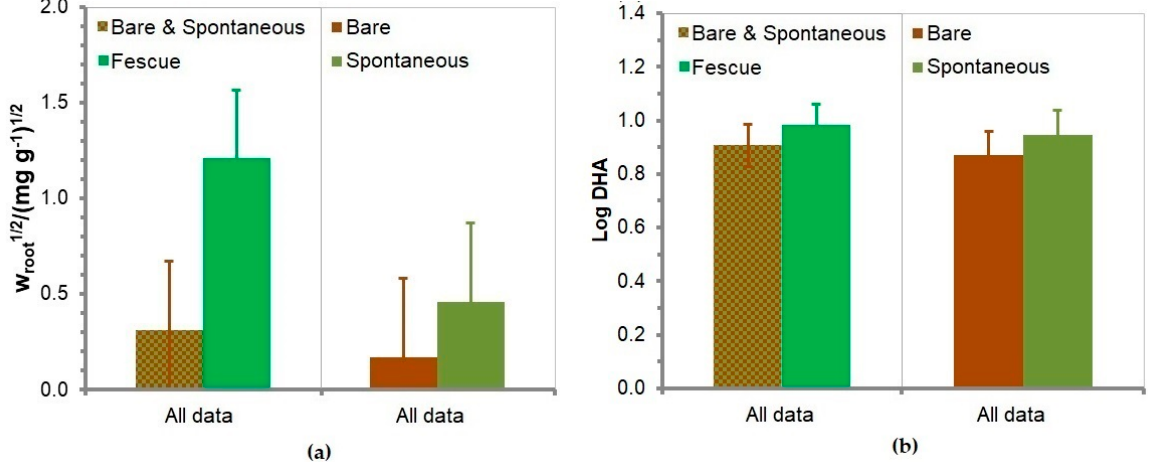
Figure 5. ( a ) Square root of the soil root mass fraction ( w root1/2 ) at 0–5 cm in the different treatments alongside the 95% confidence interval for the means according to the orthogonal contrasts based on the two-way ANOVA results; ( b ) logarithm to base 10 of the dehydrogenase activity ( DHA ) at 0–20 cm in the different treatments alongside the 95% confidence interval for the means according to the orthogonal contrasts based on the two-way ANOVA results.